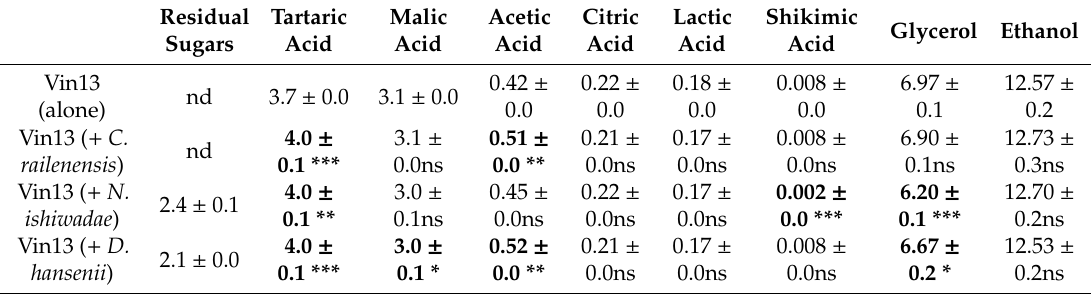
Table 1. Analytical results of the main oenological parameters resulting from the mixed-culture fermentations.